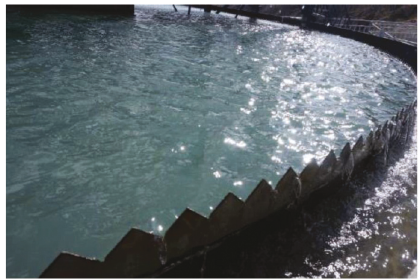
Figure 8: Overflow effect